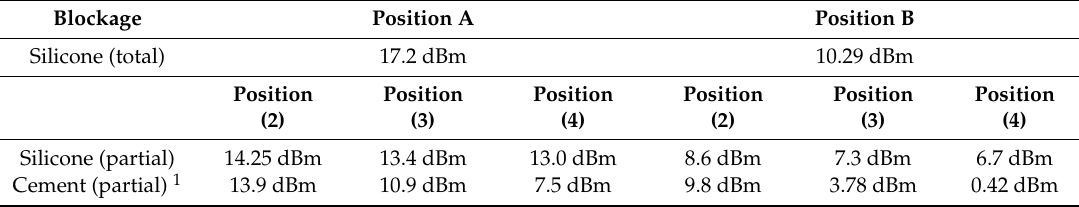
Figure 21. Positioning of the magnetostrictive transducer with respect to the clog. Table 4. Amplitude of the filtered signal (in dBm) for different types of blockage and different positions of the receiver.